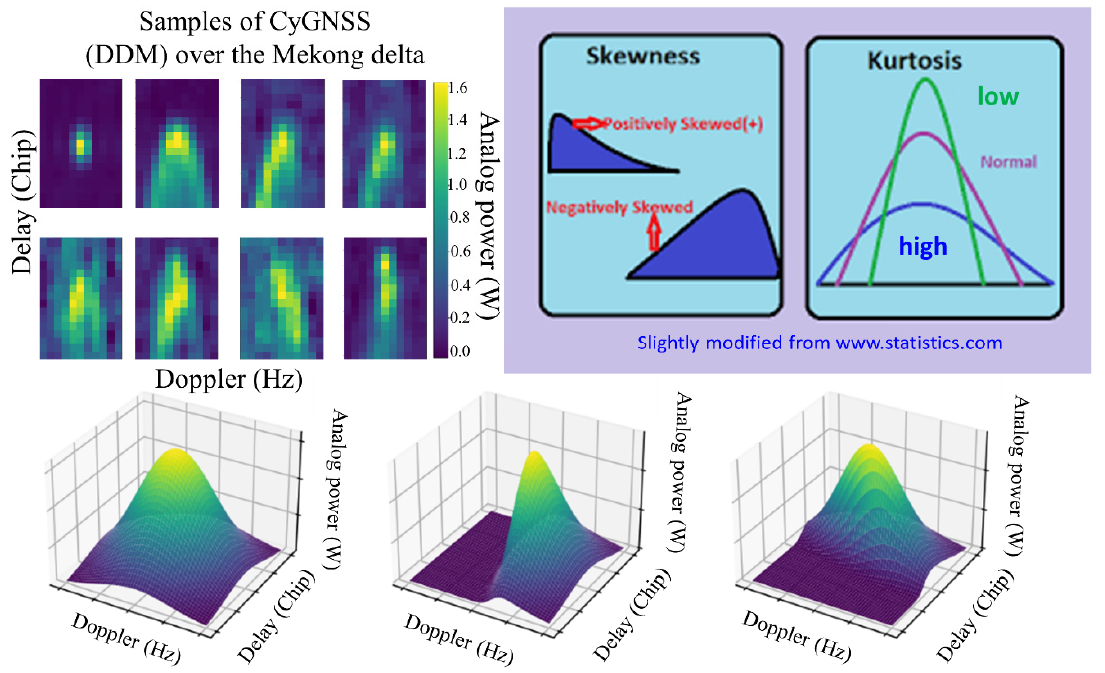
Figure 3. Illustration of DDM 3D statistics (skewness and kurtosis). The calibration is conducted by assuming that the analog power is equivalent to the probability density of the DDM 3D histogram (Delay, Doppler and Analogue power).